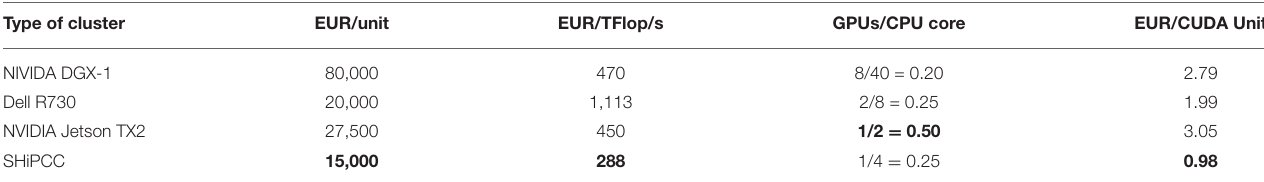
TABLE 1 | Comparison of designs for a mobile compute